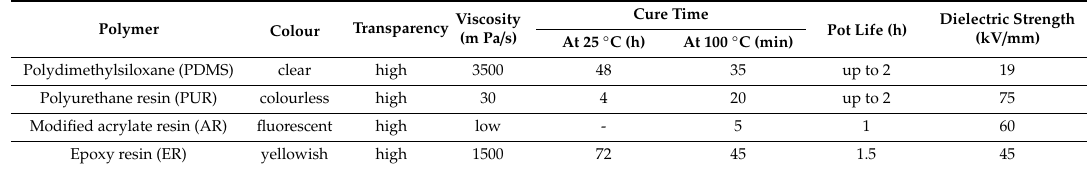
Table 1. Properties of applied polymers